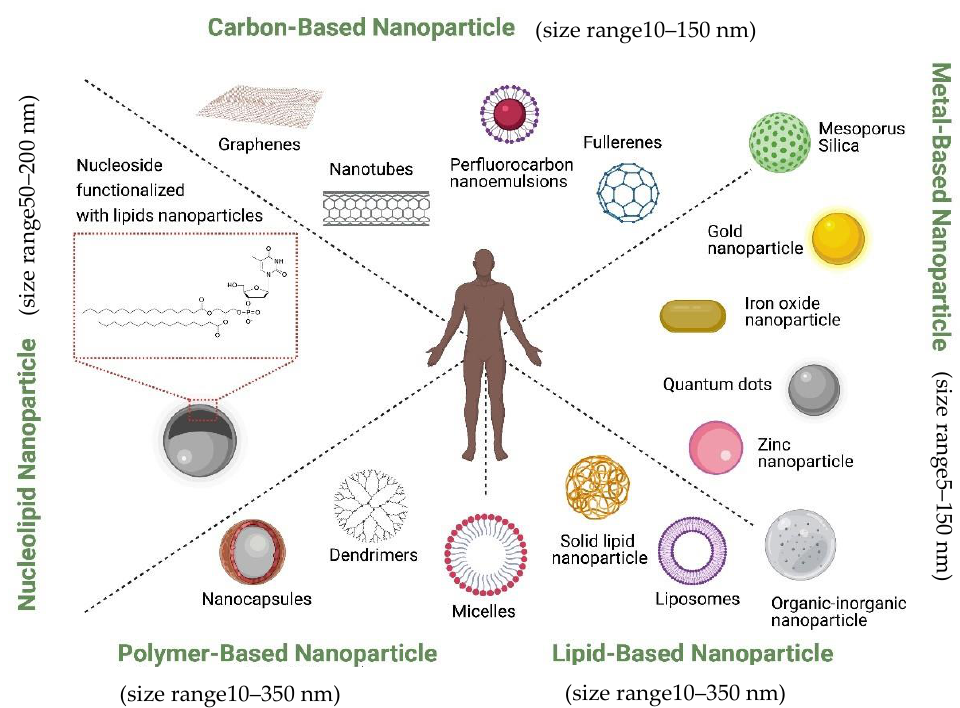
Figure 1. Schematic illustration showing the nanoparticles classified according to their chemical composition (created with